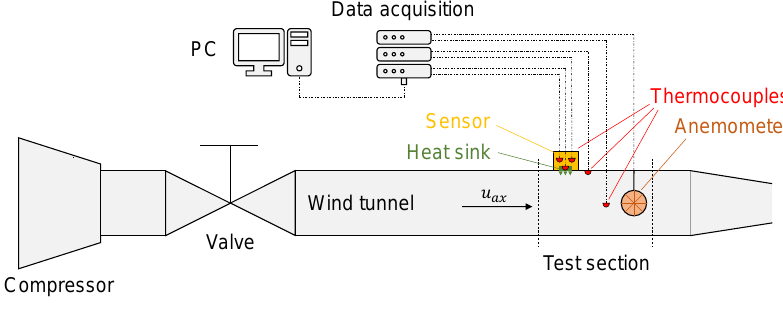
Figure 5. Schematic view of the experimental test rig for measuring the convective heat transfer coefficient of the flush-mounted heat sinks at varying Reynolds